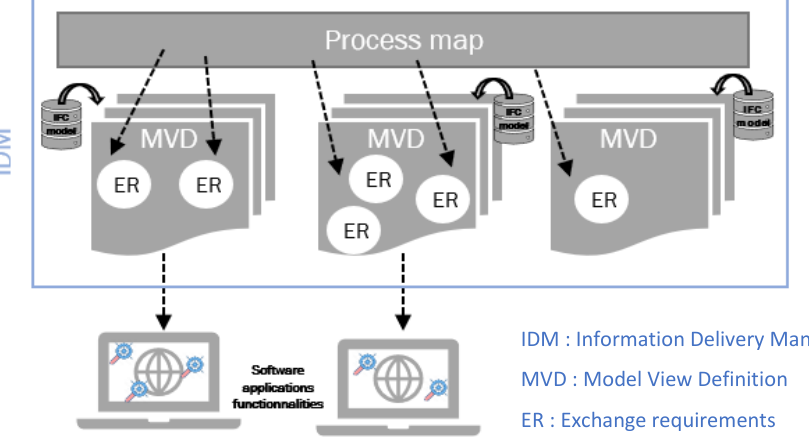
Figure 1. Description of IDM framework and its relation to BIM functional issues.